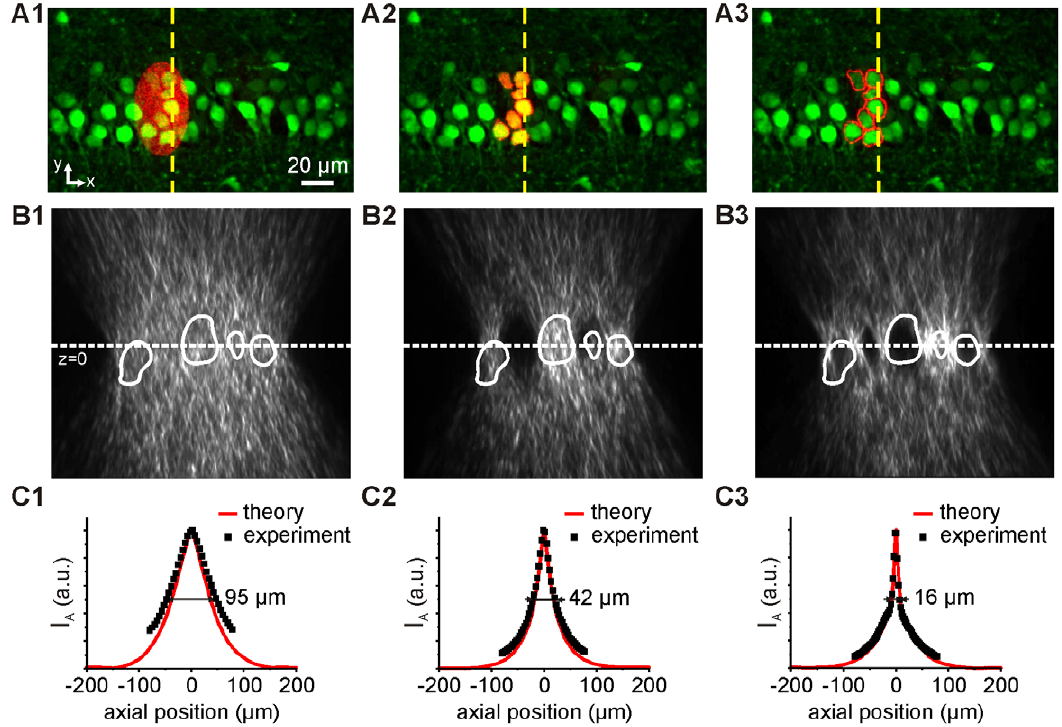
Figure 3. Holographic multiple cell photostimulation. A. Overlay of a fluorescence image recorded with HiLo microscopy showing OGB- loaded CA1 neurons of a hippocampal slice with three different excitation pattern configurations for uncaging: elliptic, shaped (cell somata) and anti- shaped (extracellular space) patterns. The superimposed red images of the excitation spots were obtained by exciting a thin layer of fluorescein. B. Measured y-z intensity cross-sections of the excitation beam along the yellow lines shown in A. The contour lines of OGB-loaded cells imaged with HiLo microscopy are superimposed (white lines). C. Distributions of calculated (red) and measured (black) axial intensities for the spots in A. The calculation was based on Angular Spectrum of Planar Wave Approximation algorithm [48]. (Figure 5B; n = 32 cells in 4 slices). In three out of four slices, few (Figure 4D, inset), while axially displacing the illumination pattern non-target neurons also responded with intracellular Ca 2 + with respect to recorded neurons (by moving the objective with steps of 3 m m). By plotting the axial distribution of the mean elevations to the stimulation (Figure 5A, right), but these normalized currents for five cells as a function of the objective focal plane position, we found a good agreement with the theoretical axial propagation expected for the corresponding holographic beam (Figure 4D; n= 5 cells in 5 different slices; for details on the calculation see Materials and Methods).